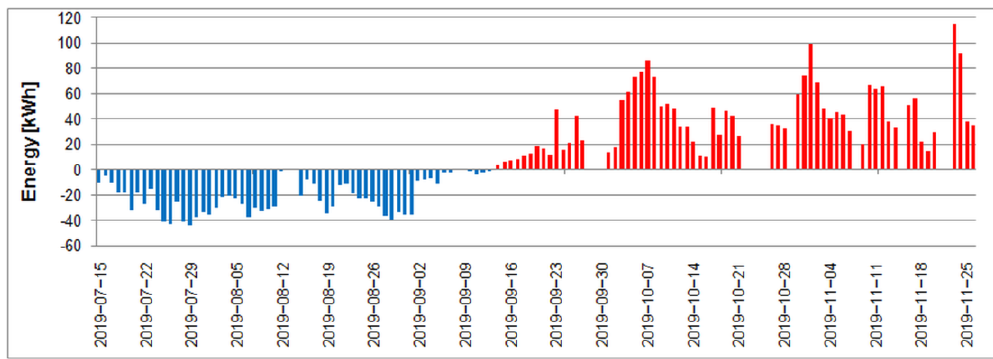
Figure 26. Daily cooling and heating energy in the analysed